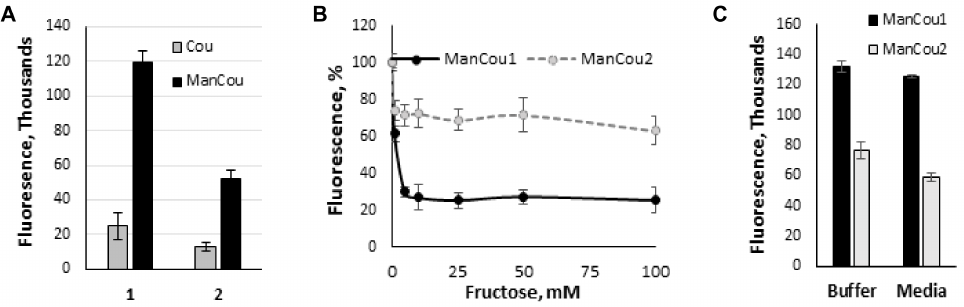
Figure 4. Analysis of sugar impact on ManCou uptake. ( A ) Comparative uptake of ManCous (black bars) vs nonconjugated (grey bars) coumarins; ( B ) fructose-induced inhibition of ManCou uptake; ( C ) ManCou uptake is independent of glucose concentration and is equally effective in the buffer and complete culture medium. All data obtained in 96-well plate format. Each data point constitutes an average of two independent experiments in triplicate. Error bars represent standard